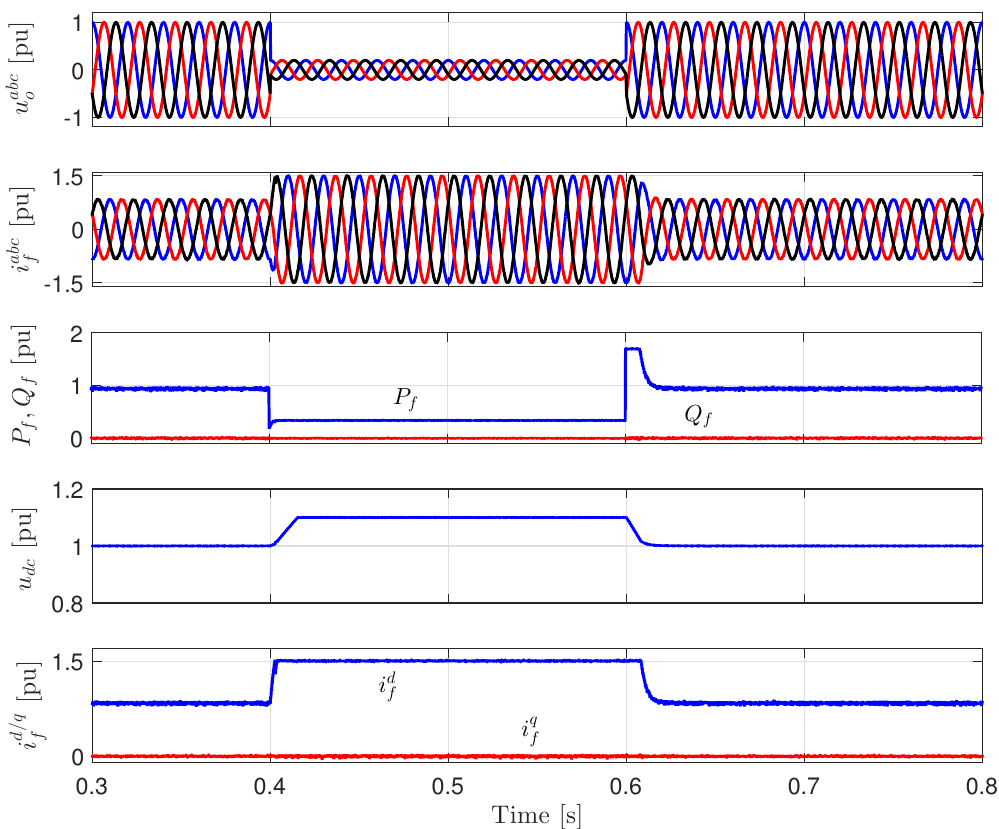
Figure 4. Performance of the GSC and DC-link during a three-phase fault with BC-FRT strategy (from top ): grid voltages u abc o = ( u a o , u b o , u c o ) (cid:62) , GSC output currents i abc reactive power injected to the grid ( P f , Q f ), DC-link voltage u dc , and d - and q -axis currents of the GSC ( i d , i q f f